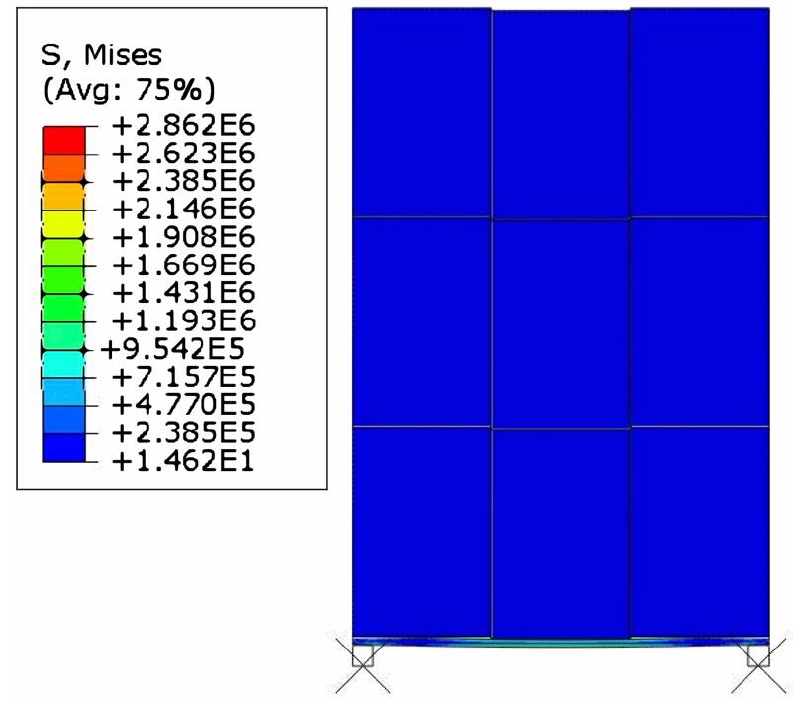
Figure 5. Plot of the equivalent Von Mises (MPa) stress of the unit load segment under a 3-column payload.